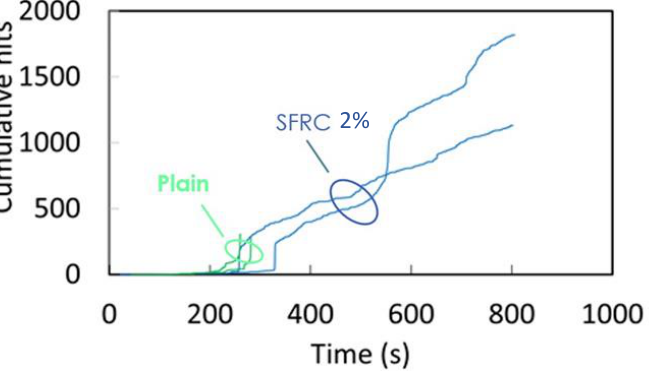
Figure 7. Cumulative AE curves for typical concrete specimens with different vol.% of steel fibers tested on 4p-bending.